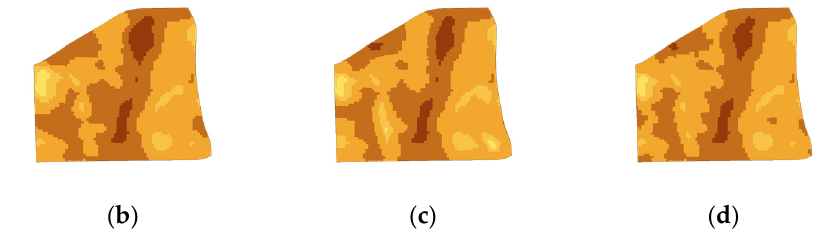
Figure 12. Simulation diagram of CO 2 concentration distribution under different schemes. ( a ) current situation. ( b ) experiment A. ( c ) experiment B. ( d ) experiment C.